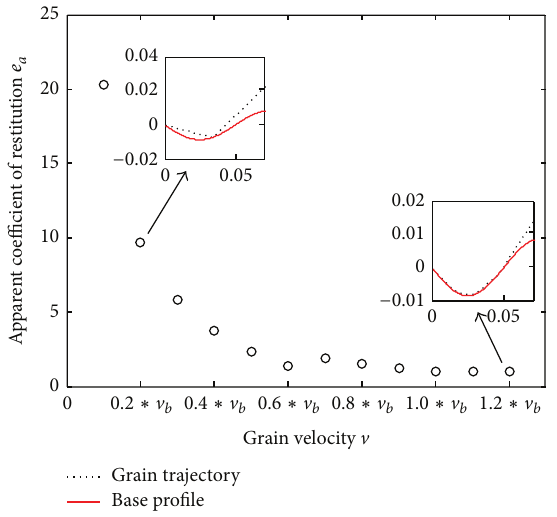
Figure 4: Variation of apparent coefficient of restitution at different incoming velocities in terms of base velocity ( V 𝑏